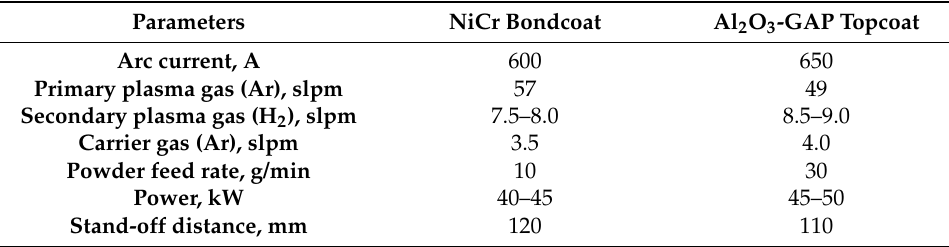
Table 1. Plasma spray parameters of Al 2 O 3 -GAP